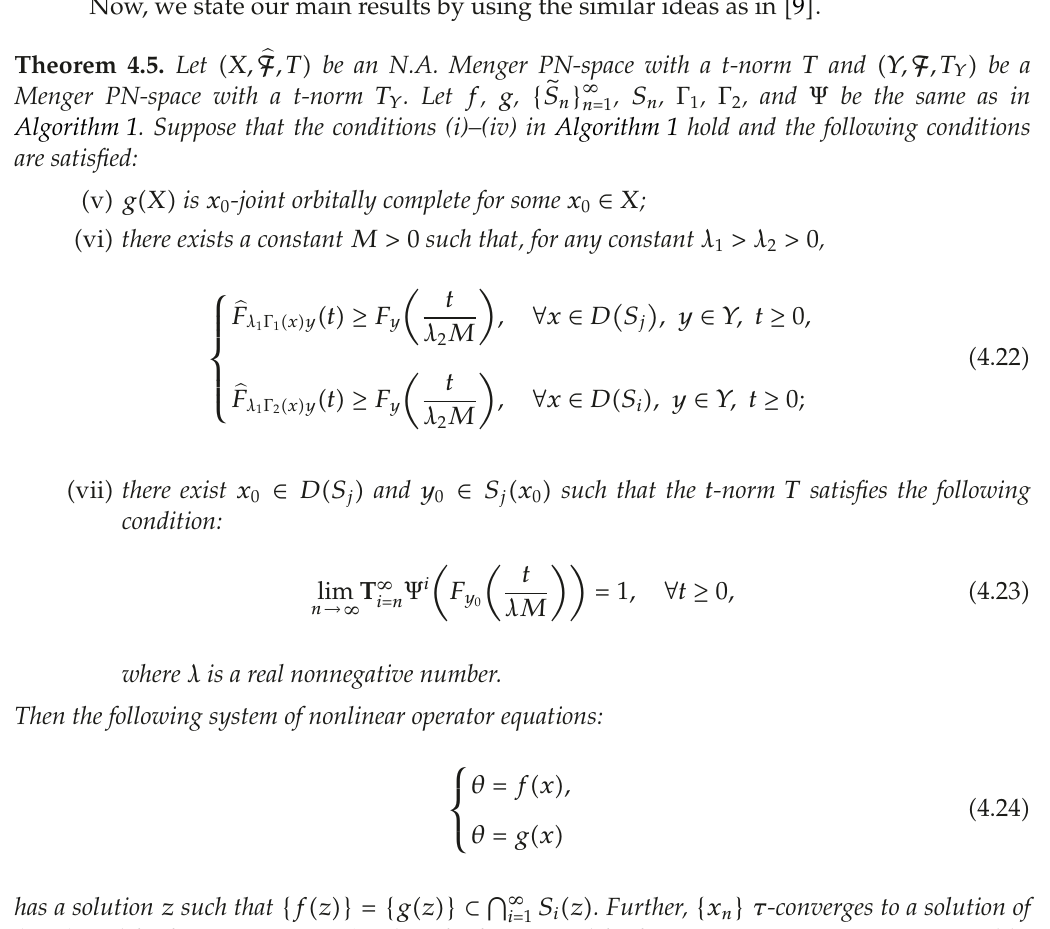
(cid:7) ∞ S n } a n (cid:9) 1